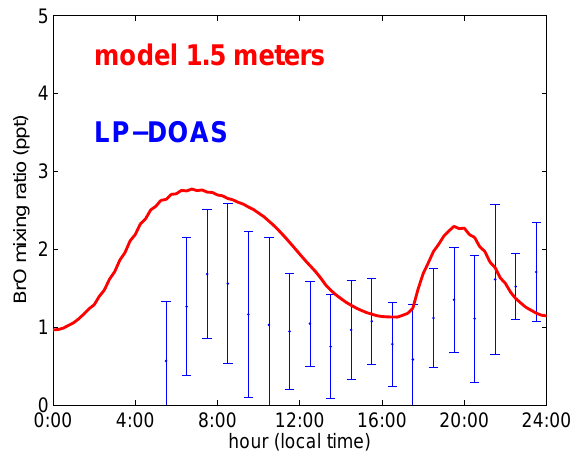
Fig. 8. Modeled BrO mixing ratios compared to the hourly aver- aged locally influenced BrO mixing ratios measured in air masses that have been over the ice sheet for at least 3 days before reaching Summit. Bars of the LP-DOAS data denote the variability of the data over the averaged days.